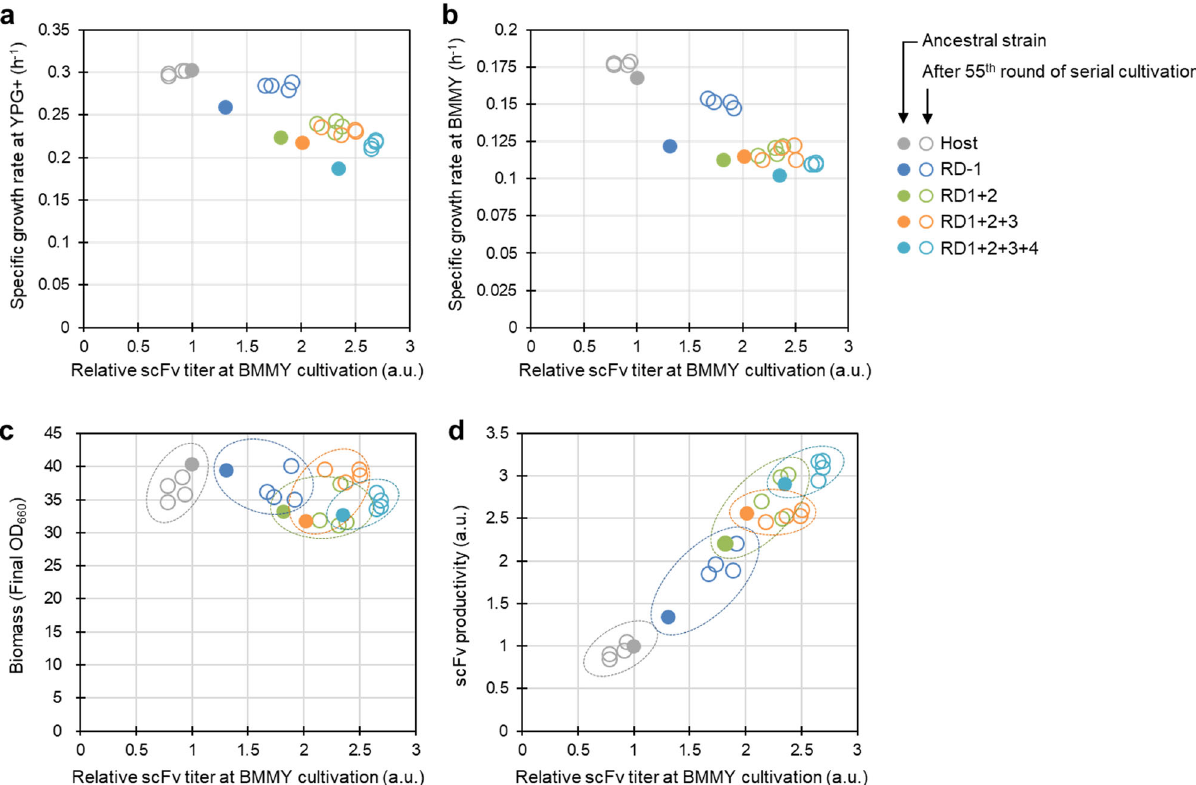
Fig. 4 Properties of the ancestral and evolved cells in the host and multiple gene-disruption-type effective factor(s) strains. a , b Speci fi c growth rate vs. relative scFv titer. Speci fi c growth rates of the ancestral strains and the evolved strains (four isolated colonies) were evaluated in YPG media supplemented with proper antibiotic(s) (YPG + ) media ( a ) and BMMY media ( b ) after the YPG + pre-cultivation. The relative scFv titers were evaluated by ELISA of supernatant of the test tube culture (pre-culture at BMGY and scFv induction at BMMY for 48h). Adaptive laboratory evolution (ALE) was conducted by 55 rounds of serial cultivation in glycerol media (YPG + ). Each of the (multiple) gene-disruption(s) and host strains was inoculated into YPG + . After cultivation at 30 °C for 24h, a small aliquot of culture was inoculated to YPG + (initial OD 660 : 0.02) ( a ) and BMMY (initial OD 660 : 0.05) ( b ) followed by cultivation at 30 °C with a Bio-photorecorder. Relative scFv titer vs biomass ( fi nal OD 660 ) ( c ) and relative productivity (d) of the ancestral and evolved strains (four isolated colonies) grown in BMMY media for 48h are shown. Filled and open circles indicate the ancestral strain and four isolated strains after the 55 th -serial cultivation, respectively. Dashed circles indicate directions of the ALE for each strain. Gray, blue, yellow-green, orange and blue-green indicate the host, RD-1, RD1 + 2, RD1 + 2 + 3 and RD1 + 2 + 3 + 4 strains, respectively. Each titer and productivity value was normalized to that of the ancestral host strain. Error bars of represent standard deviation from three technical